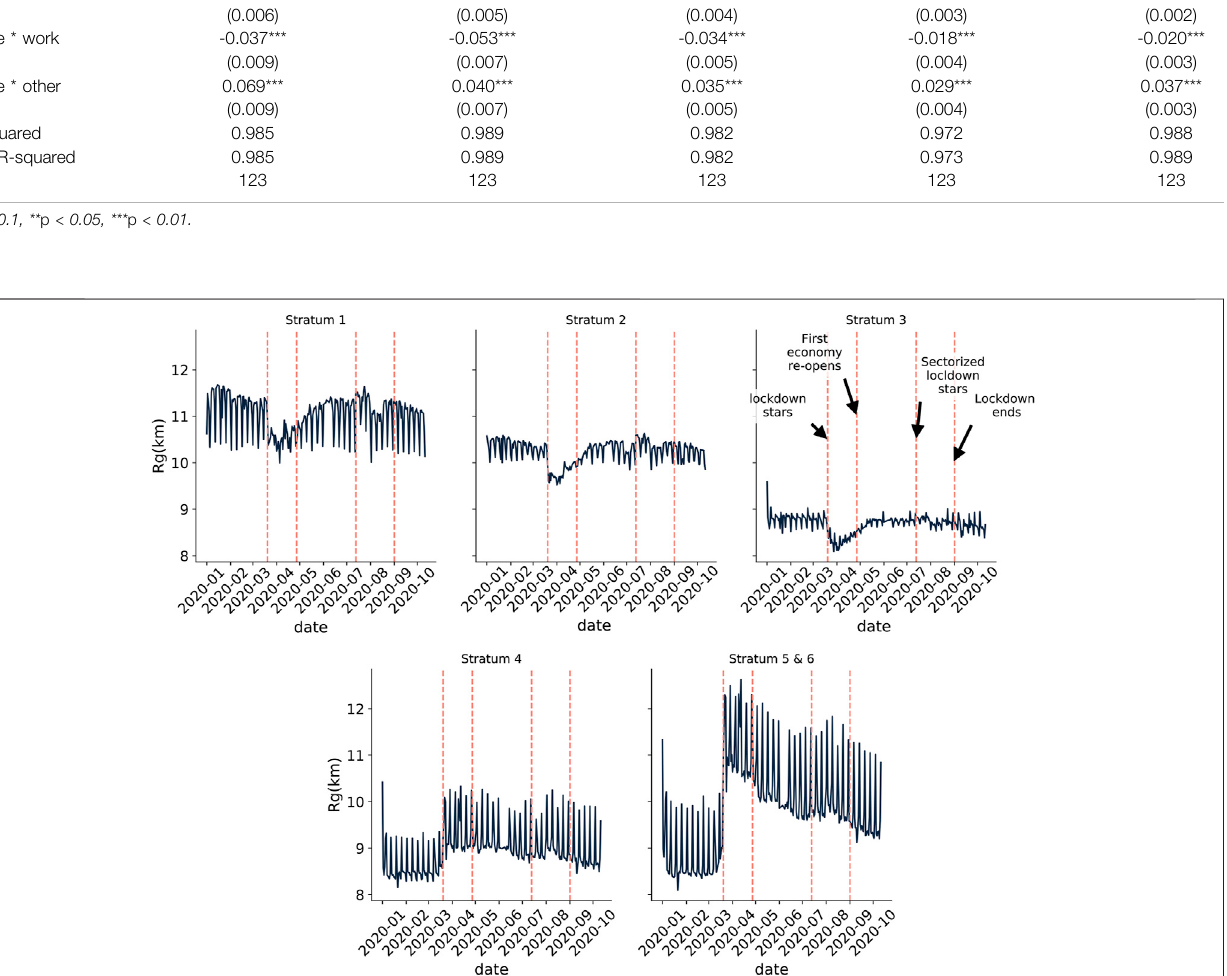
Frontiers in Built Environment |